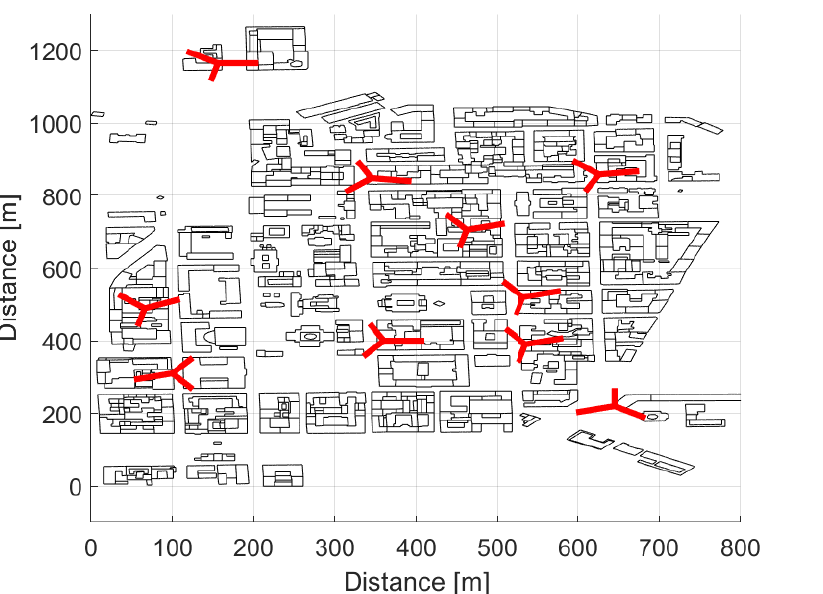
Figure 4. Area under consideration with site locations and cell